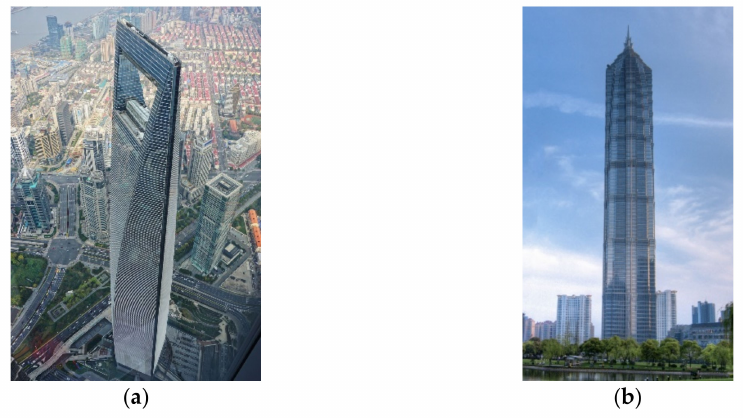
Figure 11. ( a ) Shanghai World Financial Center https://en.wikipedia.org/wiki/File:%E4%B8%8A% E6%B5%B7%E5%9B%BD%E9%99%85%E9%87%91%E8%9E%8D%E4%B8%AD%E5%BF%83.jpg (ac- cessed on 15 October 2022). ( b ) Jin Mao towers https://en.wikipedia.org/wiki/File:Jin_Mao_Tower_ 2007.jpg (accessed on 15 October 2022).